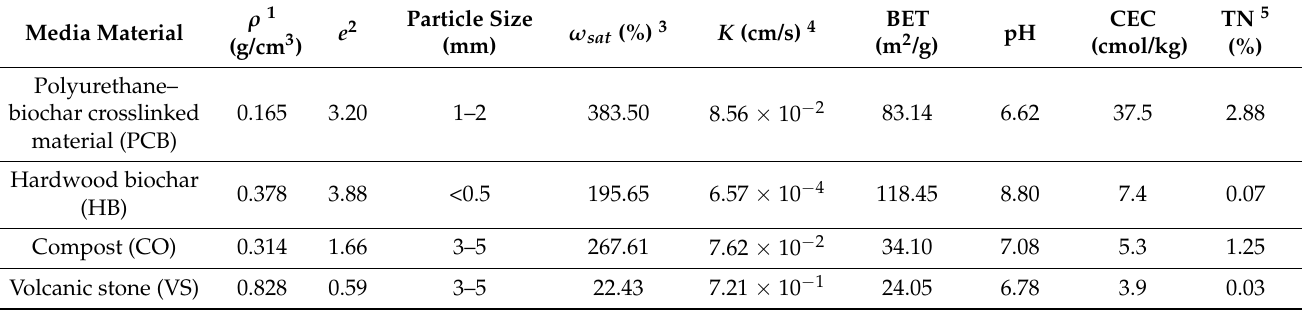
Table 1. Physicochemical properties of additive